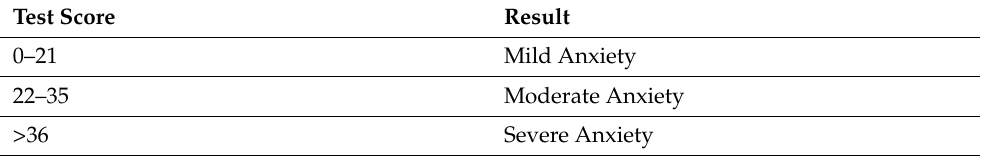
Table 9. BAI Scores